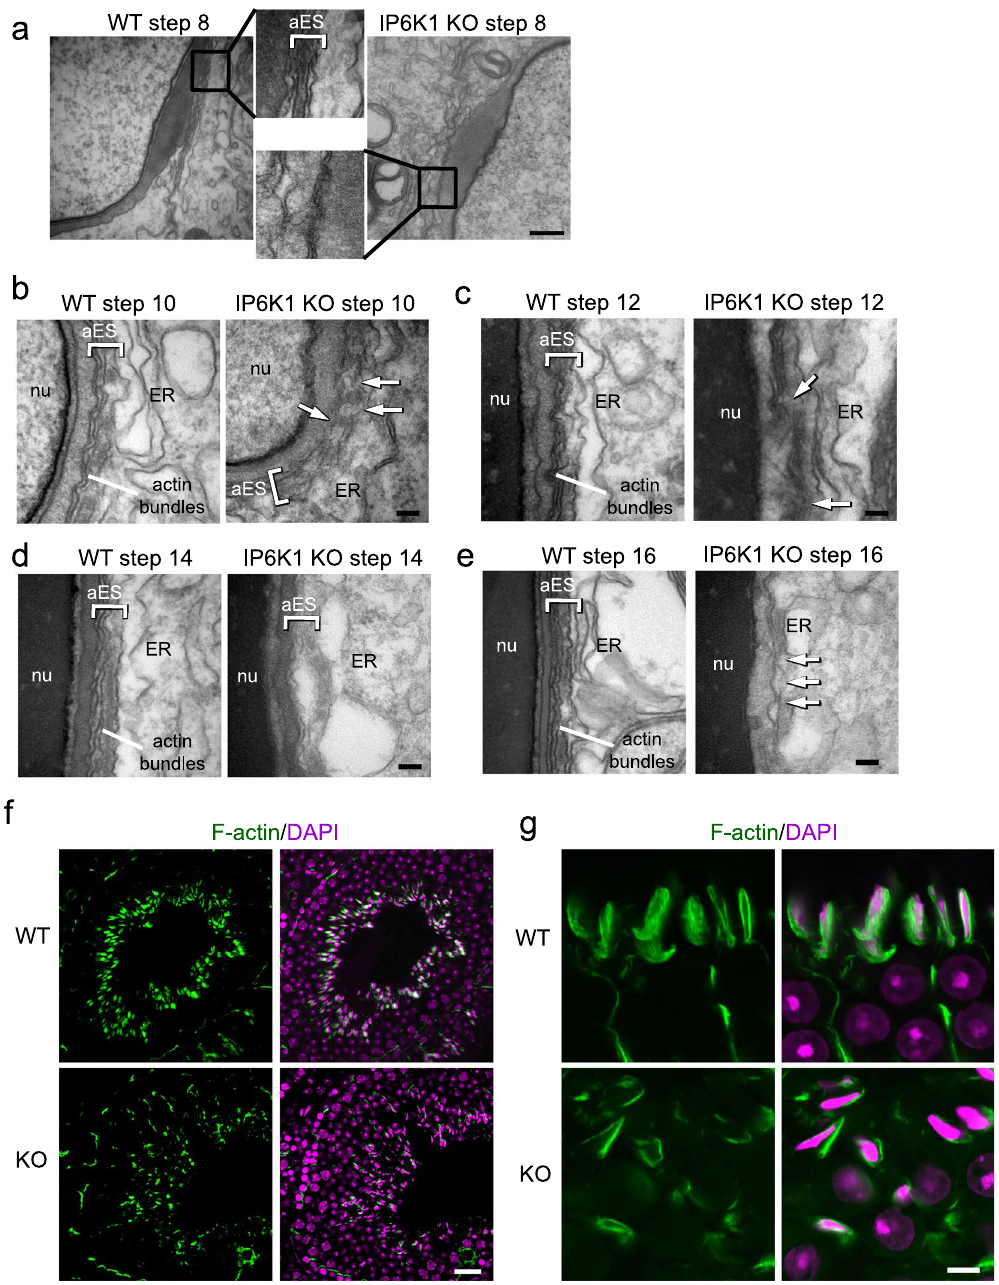
Figure 7. IP6K1 deletion disrupted apical ectoplasmic specialization. ( a–e ) Evaluation of spermatids by electron microscopy. ( a ) No characteristic apical ectoplasmic specialization (aES) was observed in step 8 spermatids of IP6K1 KOs (inset). Scale bar 500 nm. ( b ) The aES was not well formed in step 10 spermatids of IP6K1 KOs (arrows). ER: endoplasmic reticulum; nu: nucleus. Scale bar 100 nm. ( c ) Disorganized aES was seen in step 12 spermatids of IP6K1 KOs (arrows). ER: endoplasmic reticulum; nu: nucleus. Scale bar 100 nm. ( d ) Apical ES was collapsing in step 14 spermatids of IP6K1 KOs. ER: endoplasmic reticulum; nu: nucleus. Scale bar 100 nm. (e ) Apical ES collapsed in step 16 spermatids of IP6K1 KOs (arrows). ER: endoplasmic reticulum; nu: nucleus. Scale bar 100 nm. ( f and g ) The actin surrounding spermatids were decreased in IP6K1 KOs. Staining of F-actin by phalloidin on seminiferous tubules. Scale bar 20 μ m in (f); scale bar 5 μ m in